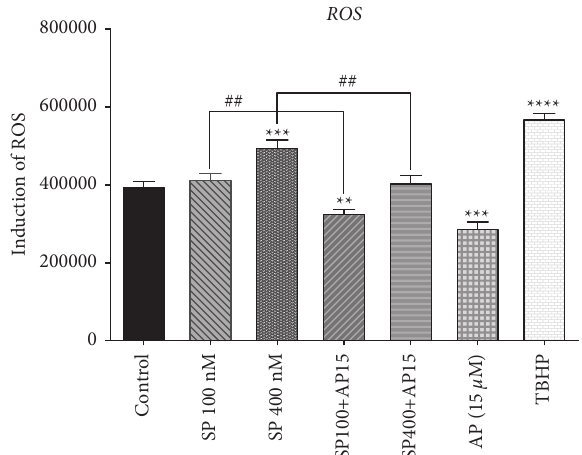
Figure 2: The effects of SP and aprepitant on intracellular ROS levels. U87 glioblastoma cells are exposed to the preferred con- centration of SP (100 and 400 nM) alone and in combination with aprepitant (15 μ M) for 24h, and ROS formation was assessed by the DCFH-DA assay. The results demonstrate that intracellular ROS production is significantly reduced in cells treated with aprepitant with or without the pretreatment with